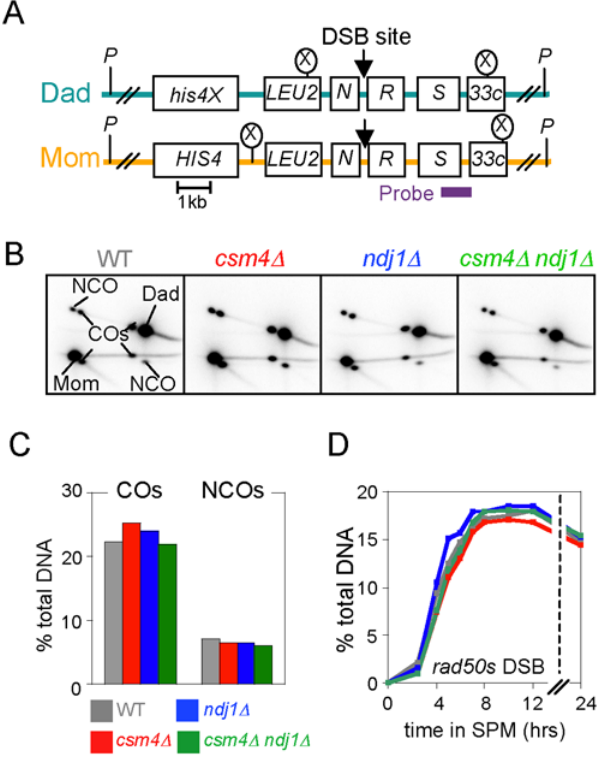
Figure 6. Meiotic recombination analysis at HIS4LEU2 in WT, csm4 D , ndj1 D , and csm4 D ndj1 D , Part I. A) Physical map of the HIS4LEU2 hotspot. Parental homologs, ‘‘Dad’’ and ‘‘Mom,’’ are distin- guished via restriction site polymorphisms (circled X= Xho I). The locations of the relevant Xho I (X), parental, and DSB sites are indicated. B, C) 2D gel analysis of CO and NCO products at HIS4LEU2. B 2D gel of CO and NCO tester constructs. Xho I digested DNA was electrophoresed in the first dimension gel for 24 h, digested in situ with Bam HI, and then electrophoresed in the second dimension gel. C) Analysis of CO to NCO products from B. D) Synchronous meiotic cultures of rad50S-KI81 mutants bearing the csm4 D , ndj1 D , and csm4 D ndj1 D mutations were analyzed by Southern blot for DSBs at the HIS4LEU2 locus. Quantitation is shown for gels presented in Figure S3B.